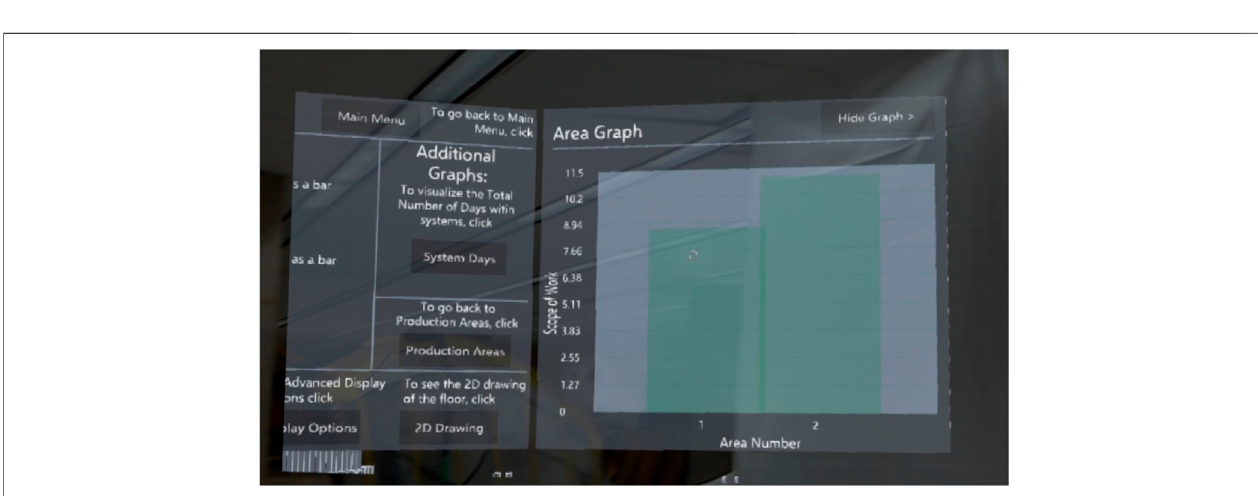
FIGURE 7 | Automated bar chart of scope of work within the different production areas of the selected activity.